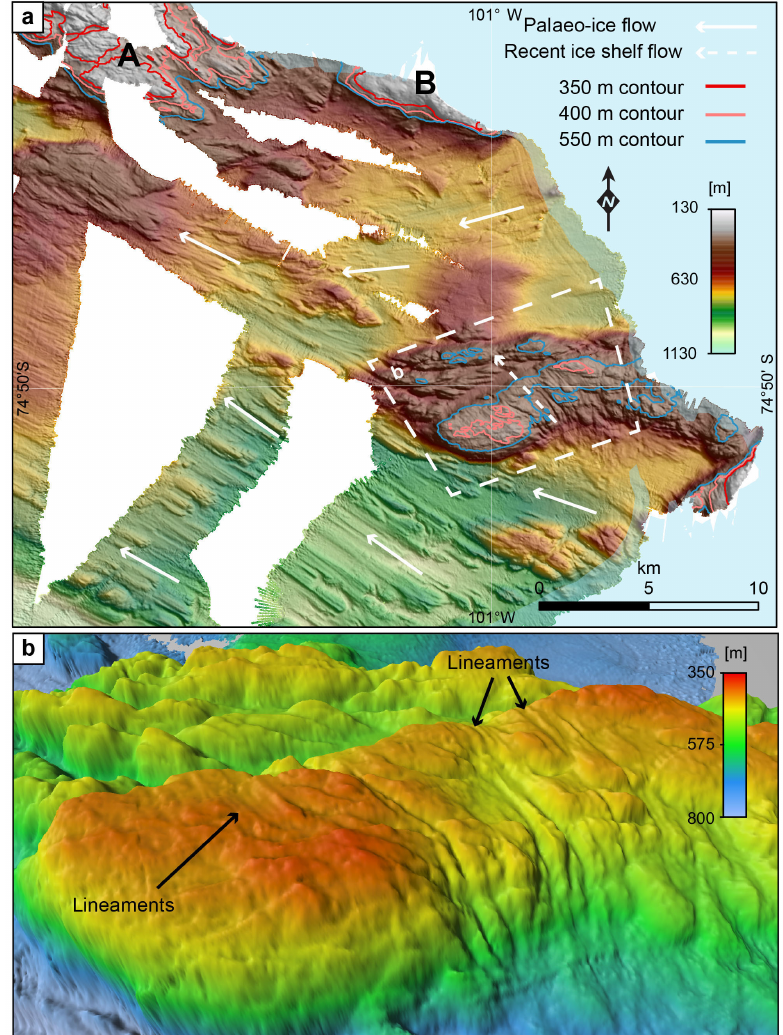
Figure 2. Bathymetry of submarine ridge and adjacent sea floor at 25m grid resolution. (a) Hill-shaded plan view with 350, 400 and 450m contours. Note the shoal areas in the north-west, labelled A and B. Palaeo-ice flow inferred from drumlins and lineations are shown by white arrows, and direction of recent ice-shelf flow is shown by dashed arrows. Light blue area delineates ice-covered area at time of data acquisition as shown in Fig. 1. (b) 3-D view of submarine ridge showing subtle lineaments oriented in the same direction as recent ice-shelf flow on its